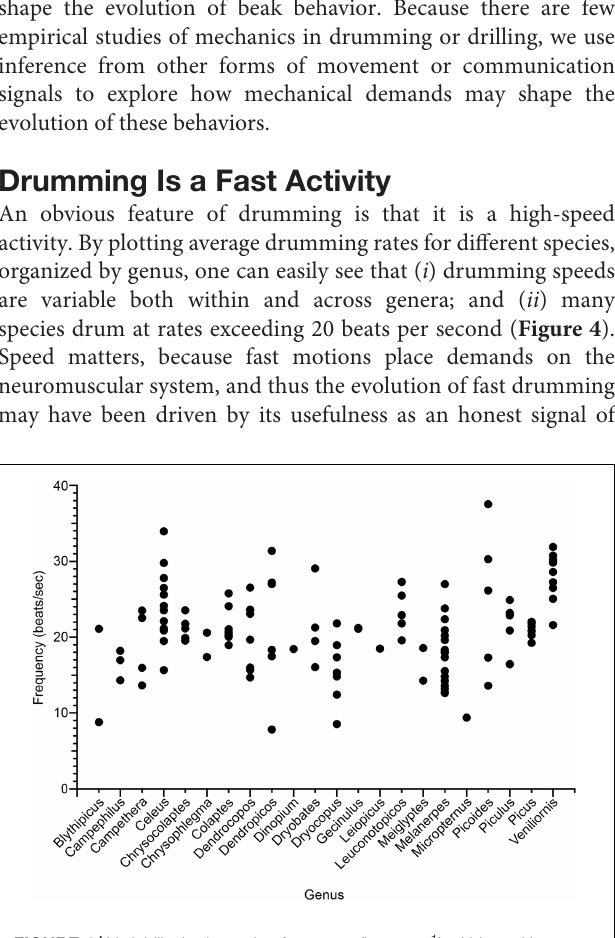
FIGURE 4 | Variability in drumming frequency (beats s − 1 ) within and between 22 woodpecker genera. Each point represents the mean ( n ≥ 2) frequency of a single species extracted from audio recordings accessed through the Macaulay Library at the Cornell Lab of Ornithology and Xeno-canto (data from Miles et al.,